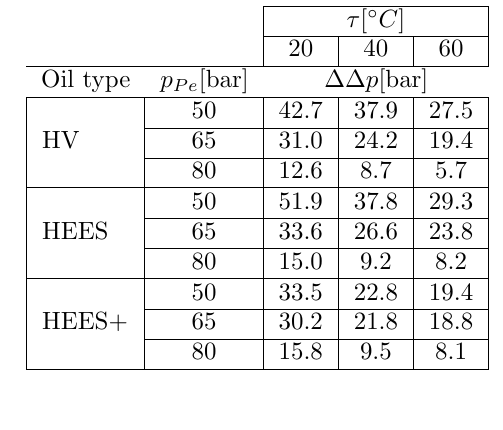
Table 5: ∆∆ p for 20, 40 and 60 ◦ C for the p Pe =50bar, p Pe =65bar and p Pe =80bar data sets and all three oils.